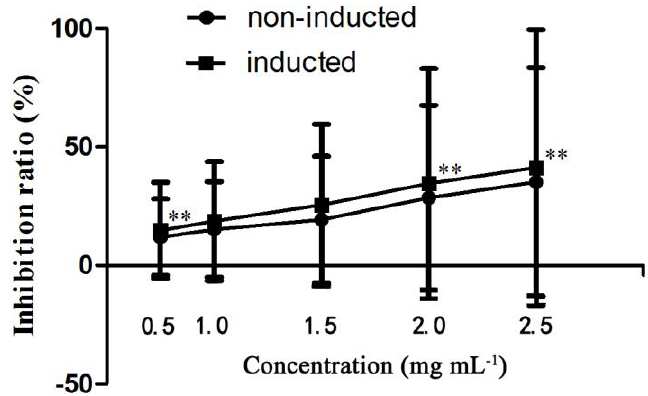
Figure 8. The antiproliferative effects of inducted ginseng adventitious roots on HepG2 cells. Data represents the mean ± standard deviation of three replicates. ** The very significantly different values between same content of inducted and un-inducted groups at p < 0.01.